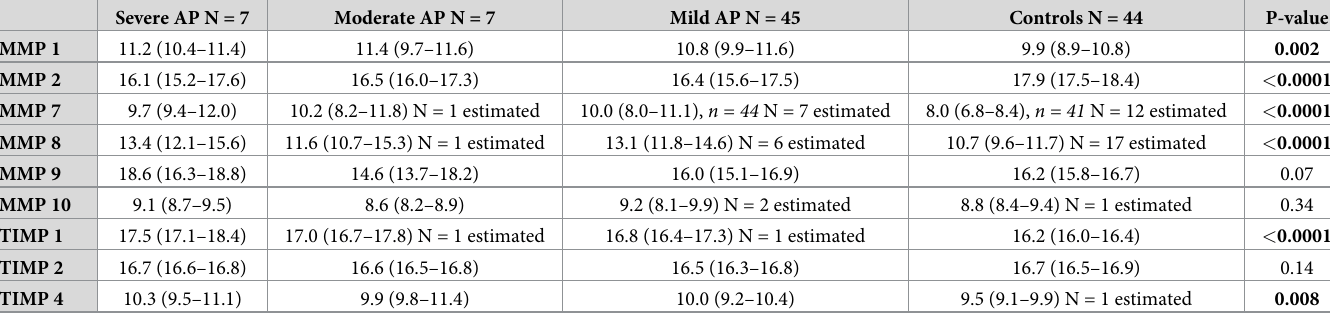
Table 2. MMPs and TIMPs: SAP vs moderate AP vs mild AP vs